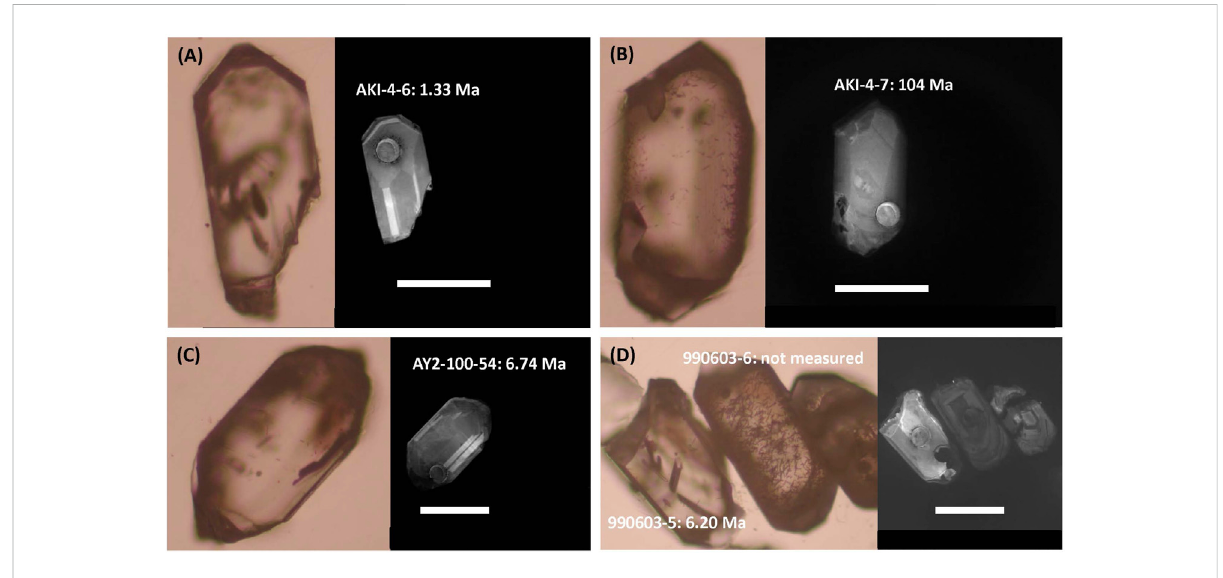
FIGURE 5 Representative etched zircon images (A – D) with sample names and U-Pb ages. Note that the sample 990603-6 in (D) was not U-Pb dated becauseofahigh fi ssiontrackdensity.Cathodoluminescence(CL)imageswereobtainedusingaHitachiTM4000Pluselectronmicroscope.Circular craters in CL images are laser-ablated pits of ~30 μ m in diameter. Scale bars in CL images are 100 μ